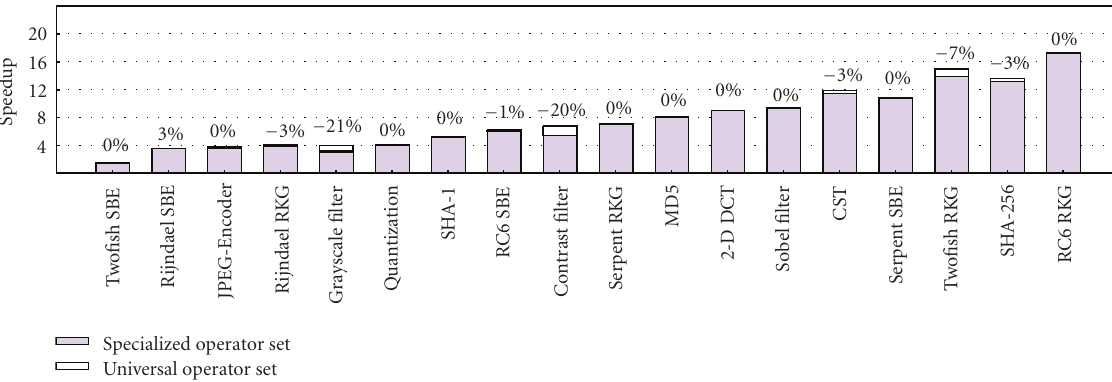
Figure 13: Speedup of benchmark applications on a specialized 8 operator array with 3 multiplication operators and 1 division operator.